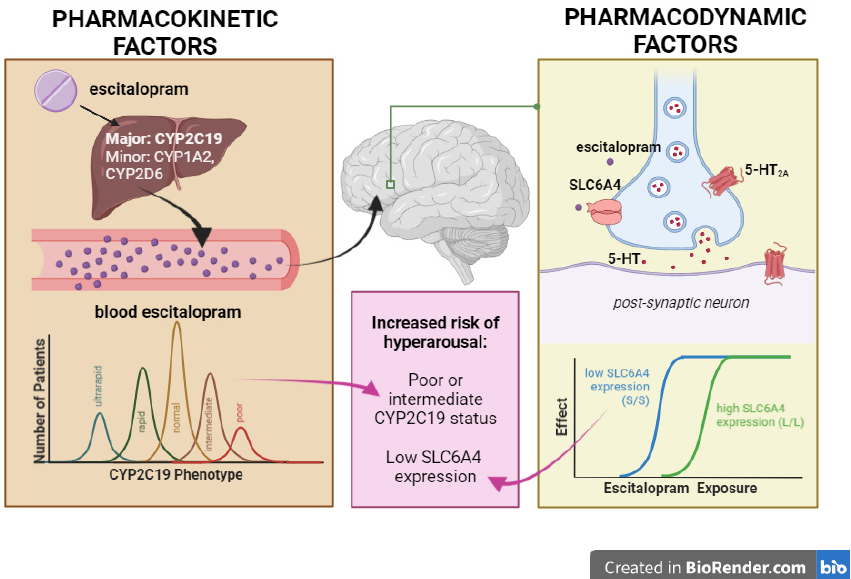
Figure 1. Escitalopram is predominantly metabolized by CYP2C19, and reduced CYP2C19 metabolism has been associated with increased risk of hyperarousal in youth at high risk for bipolar disorder. Youth homozygous for the “short (S)” allele of SLC6A4 exhibit reduced SLC6A4 and greater rates of adverse drug events. Furthermore, 5-HT2A may play a role in escitalopram pharmacody- namics, but its role in the development of hyperarousal or bipolar disorder is less clear. Adapted from Strawn et. al. (2021) [80].